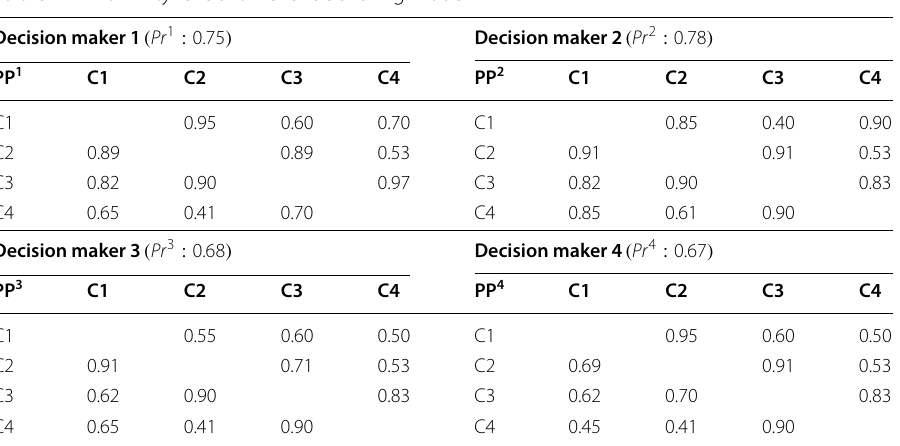
Table 12 Proximity levels for revenue sharing model Decision maker 1 ( Pr 1 : 0.75